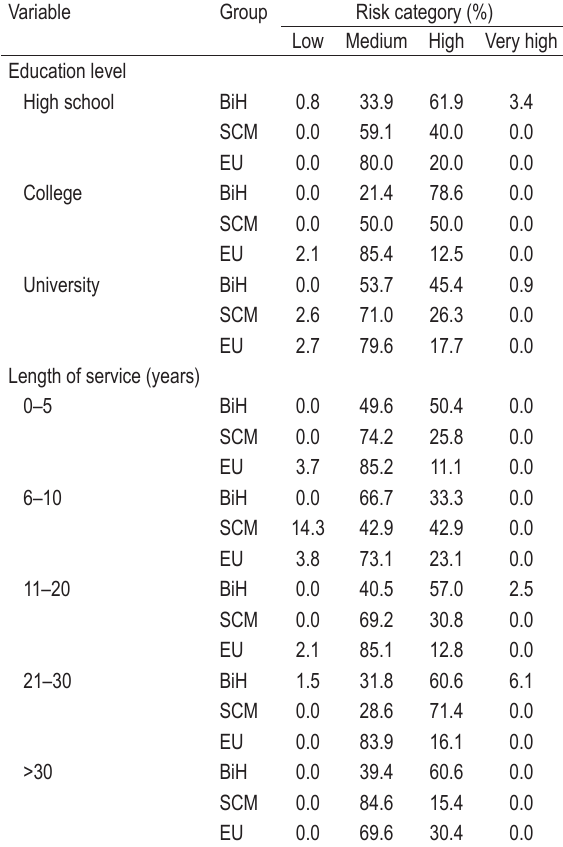
TABLE 4. Classification of occupational risk according to level